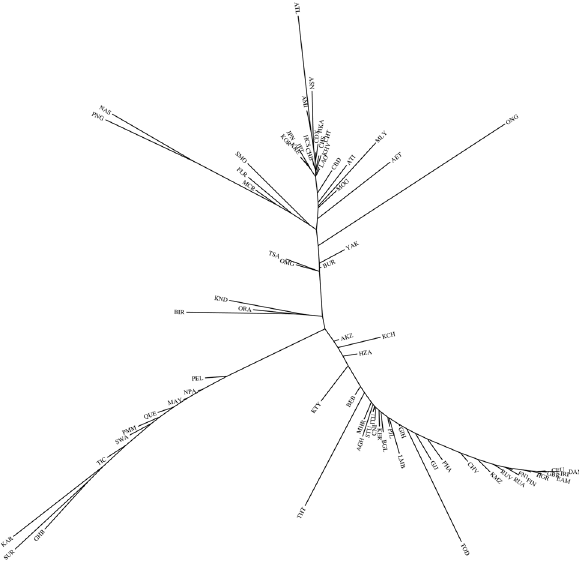
Figure 6. Best exact Least Squares tree for 74 populations. This best of 445 different trees examined has no internal negative segments but does have eight external negative segments to the CHV, FIN1, GIH, PJL, BEB, PEL, BUR, and JPT populations. In their local positions in the graph the segments are small in absolute value and are indicative of small deviations from true additivity in their pairwise genetic distances. They generally are located in reasonable locations with respect to what is known about their relationships. For example, the FIN1 sample from 1 KG clusters with the independent FIN sample from Kidd